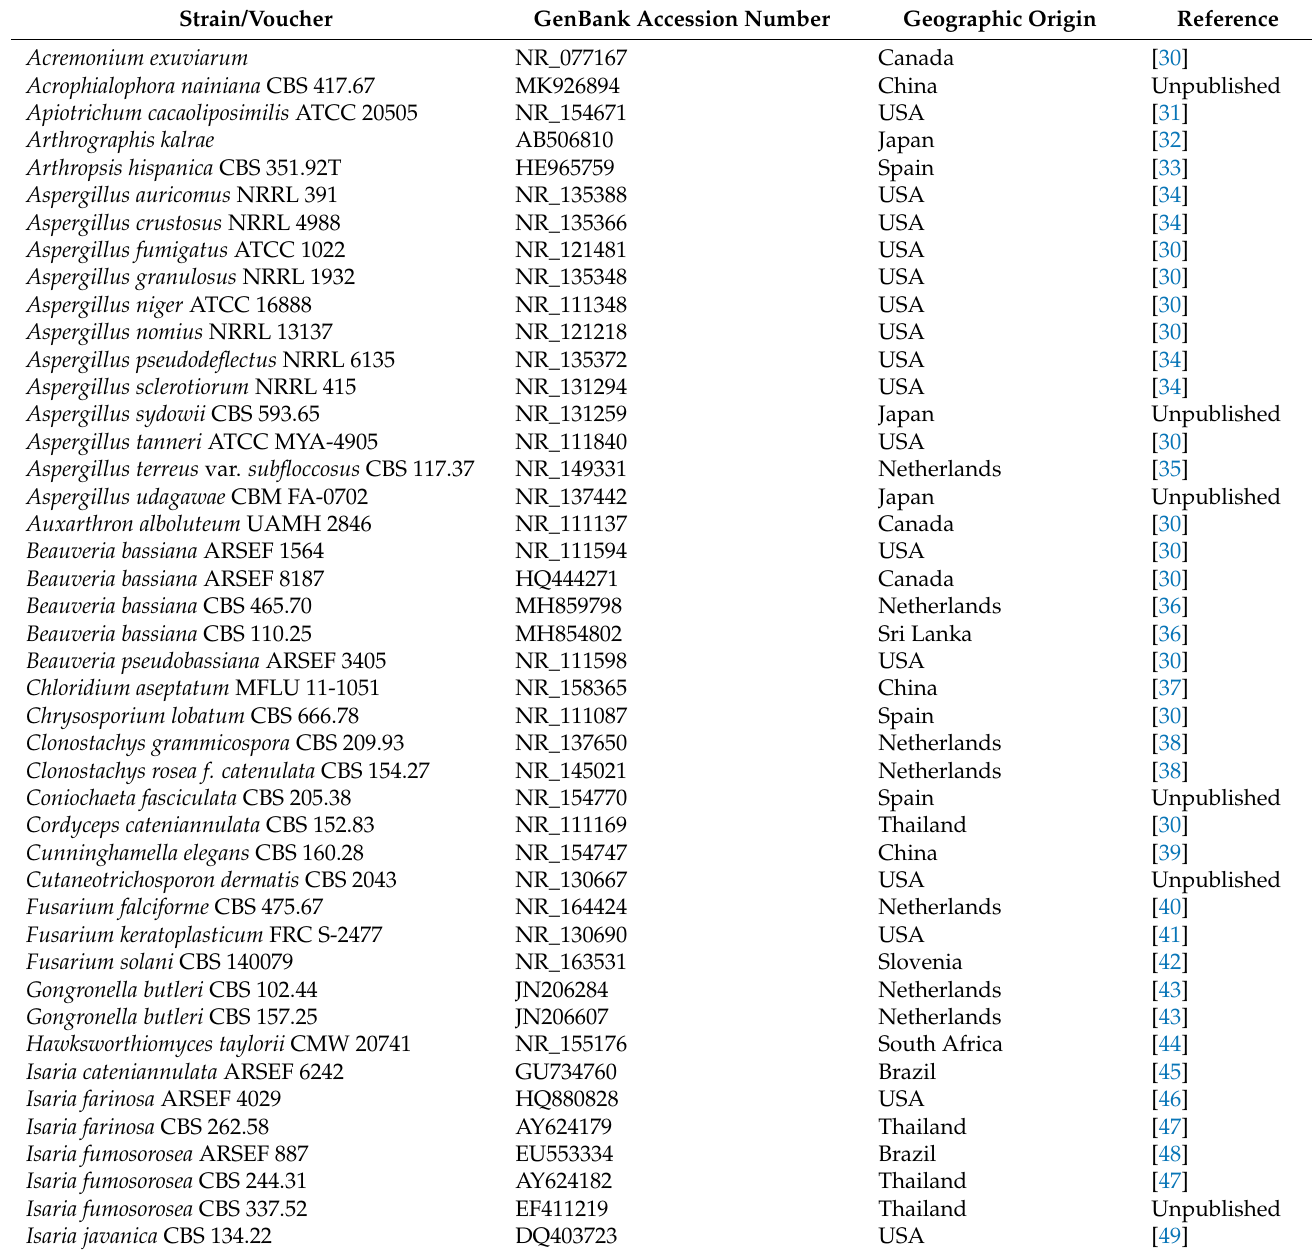
Table 1. The information of referred fungal